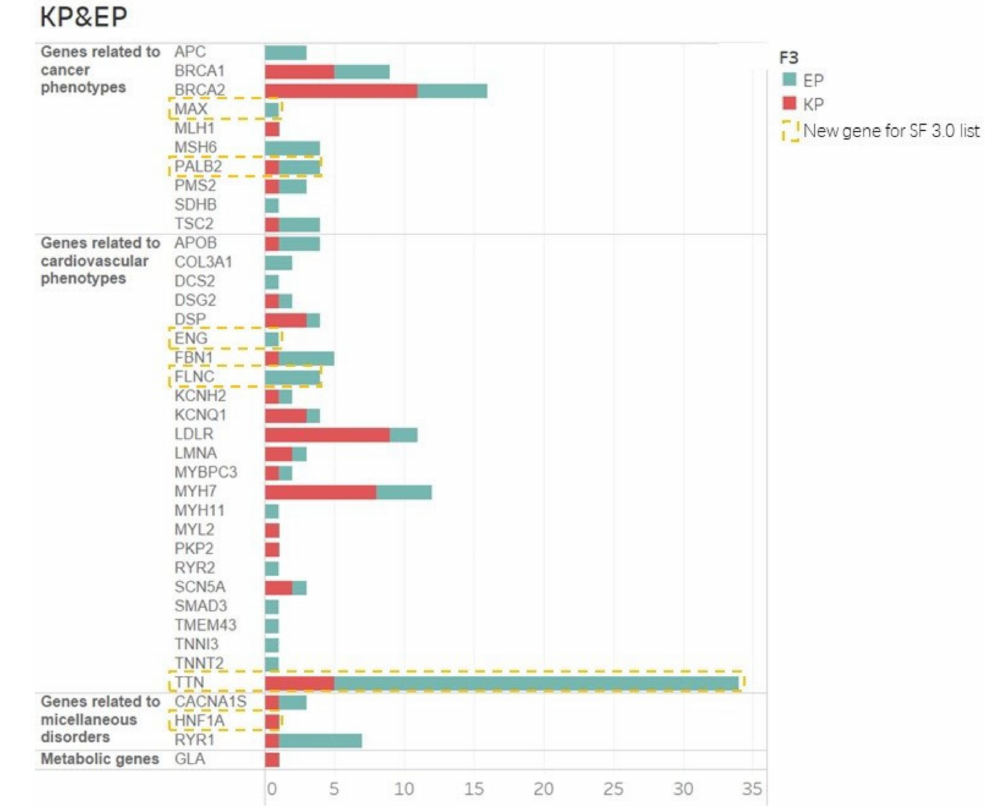
Figure 2. An overview of secondary findings (SFs) in this